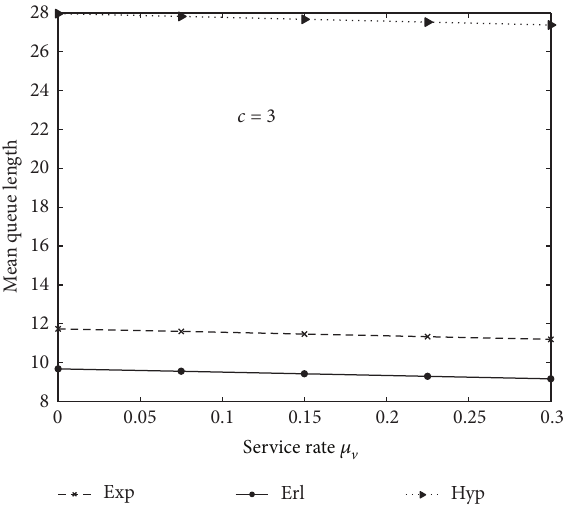
Figure 7: Mean queue length versus vacation-service rate with 𝜌 = 0.1 , 𝜉 = 10 , 𝜃 = 0.1 , and 𝑐 = 1 .